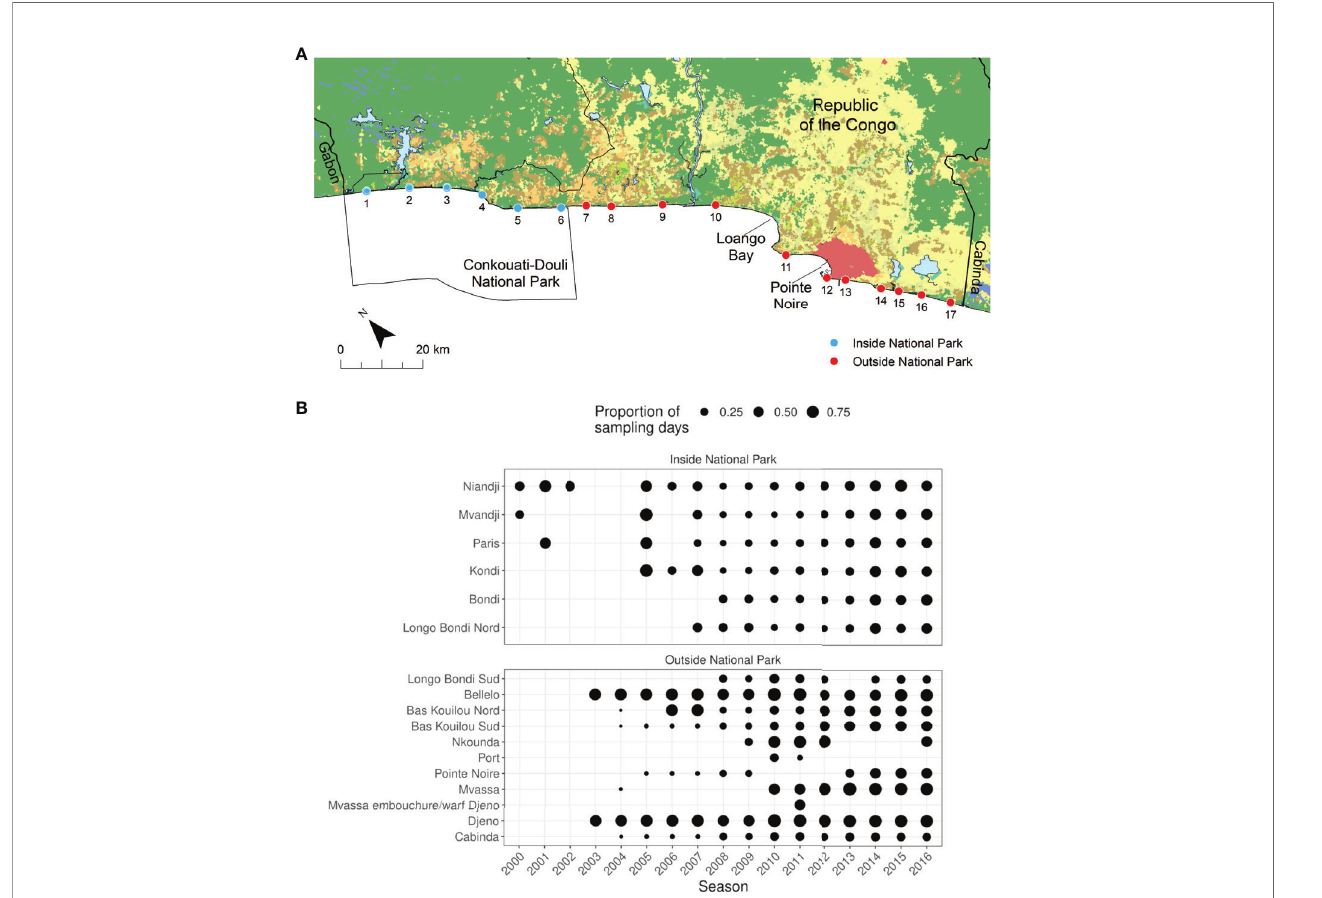
FIGURE 1 | Location of the 17 nesting beaches monitored across 17 nesting seasons between 2000/2001 and 2016/2017 (A) and sampling effort at those sites shown as the proportion of sampling days in the season (241 days between September and April) that each site was surveyed (B) . Beach names: 1. Niandji, 2. Mvandji, 3. Paris, 4. Kondi, 5. Bondi, 6. Longo Bondi Nord, 7. Longo Bondi Sud, 8. Bellelo, 9. Bas Kouilou Nord, 10. Bas Kouilou Sud, 11. Nkounda, 12. Port, 13. Pointe Noire, 14. Mvassa, 15. Mvassa embouchure/warf Djeno, 16. Djeno, and 17. Cabinda. (see Figure S1 for further detailed information in variability in monitoring effort over time at each site). Habitat data (terrestrial shading) derived from Global Land Cover